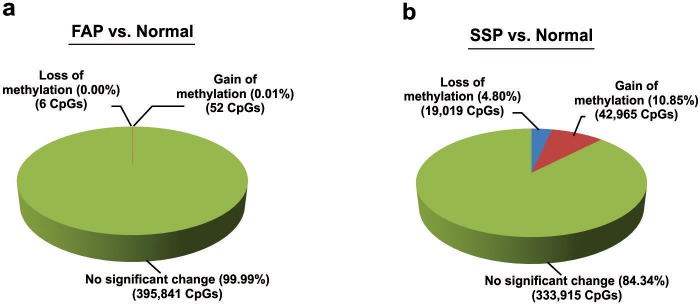
Global methylation changes in SSP and FAP.(a) Comparison of FAP with normal samples shows only few DNA methylation changes. From 395,899 CpGs tested on the Infinium array, only 52 CpGs show more than 2 fold increase in methylation in FAP compared to normal colon tissue and 6 CpGs show more than 2 fold reduction in methylation (p-value <0.05). (b) In contrast comparison of SSP with normal samples shows significant DNA methylation changes. From 395,899 CpGs tested on the Infinium array, 42,965 (10.85%) show more than 2 fold increase in methylation in SSP compared to normal colon tissue and 19,019 (4.80%) show more than 2 fold reduction in methylation (p-value <0.05).